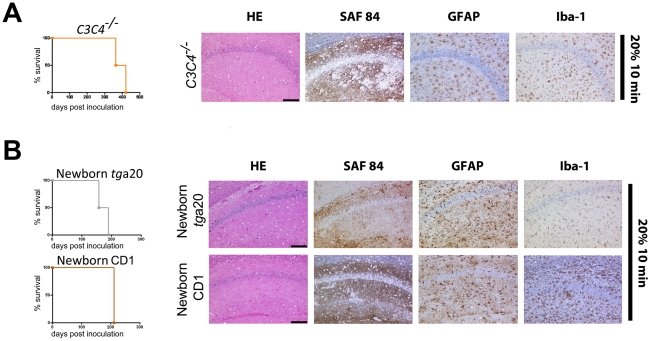
Prion transmission through aerosols in complement-deficient and newborn mice.(A) C3C4
−/− mice and (B) newborn tga20 and CD1 mice were exposed for 10 min to a 20% aerosolized IBH. Survival curves (right panels) as well as histological and immunohistochemical characterization of hippocampi indicate that all prion-exposed mice developed scrapie efficiently. Scale bars: 100µm.